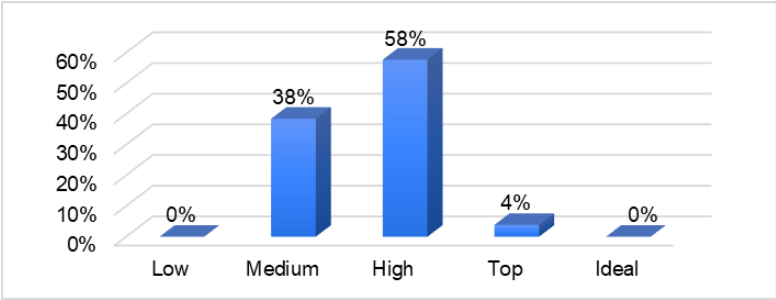
Figure 5. The proportions of readiness levels of all indicators.